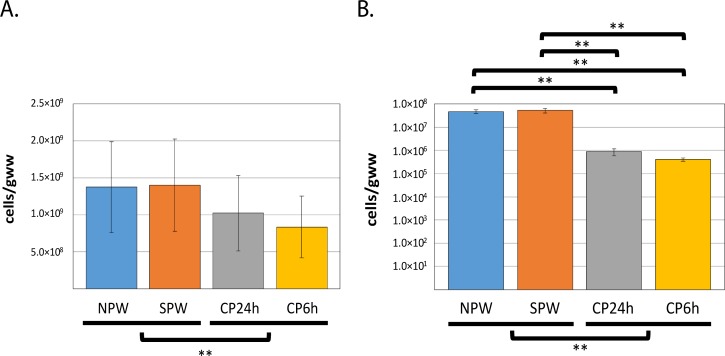
Concentration of bacteria and methanogens in the cecum of wild and captive ptarmigans.Bacteria (A) and methanogens (B) populations were estimated by qRT-PCR. Total counts are presented as number of cells per gram of wet weight (cells/gww). Bacterial counts were plotted using a linear scale whereas for methanogens a logarithmic scale was applied for better visualization. Wild rock ptarmigan northern Norway (NPW) (n = 4); wild Svalbard rock ptarmigan (SPW) (n = 4); captive Svalbard ptarmigan exposed to long (CP24h) (n = 4) or short (CP6h) (n = 4) photoperiods. Pair-wise statistical comparisons were calculated with a two-tailed Student’s t-test. Statistical analysis for multiple groups were calculated with ANOVA tests. Tukey´s range test was applied for further verification at group level * (p-value<0.05); ** (p-value<0.01).